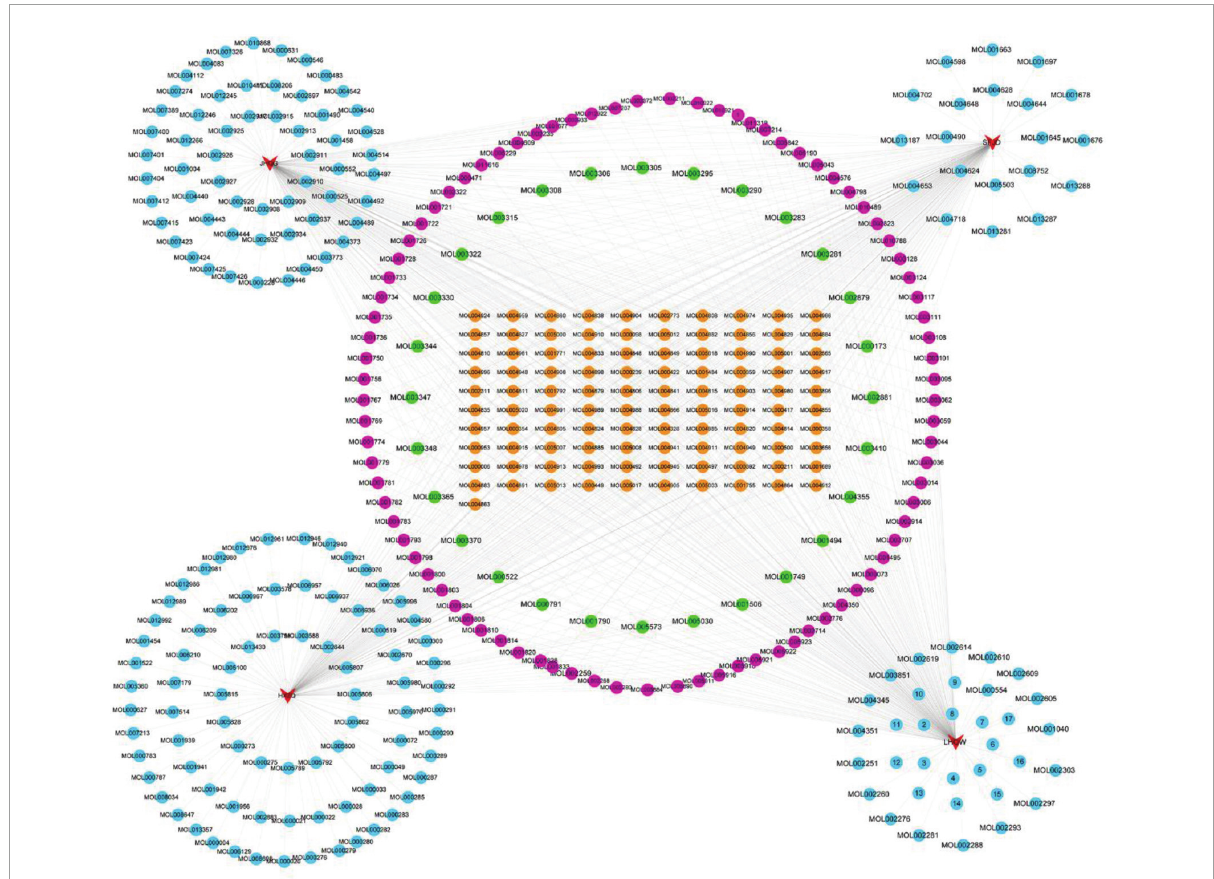
FIGURE8 Active component-common active component network of the four prescriptions. The red triangles represent the four prescriptions; the Orange, green, rose red, and sky blue circles represent the common active ingredients of the four prescriptions, the common active ingredients of three prescriptions, two prescription common active ingredients, and each prescription unique active